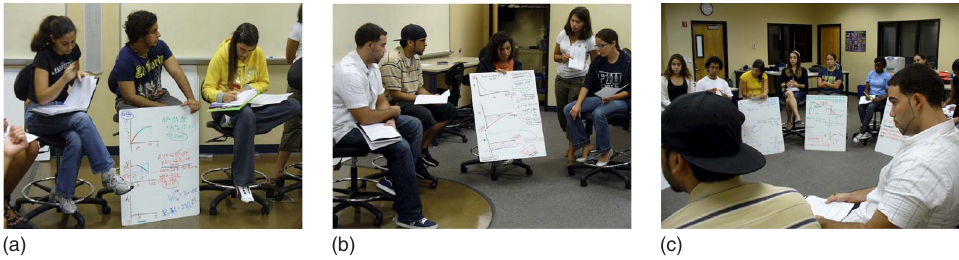
FIG. 1. (cid:1) Color (cid:2) (cid:3)(cid:1) a (cid:2) – (cid:1) c (cid:2)(cid:4) Student participation in model construction. Photo credit: